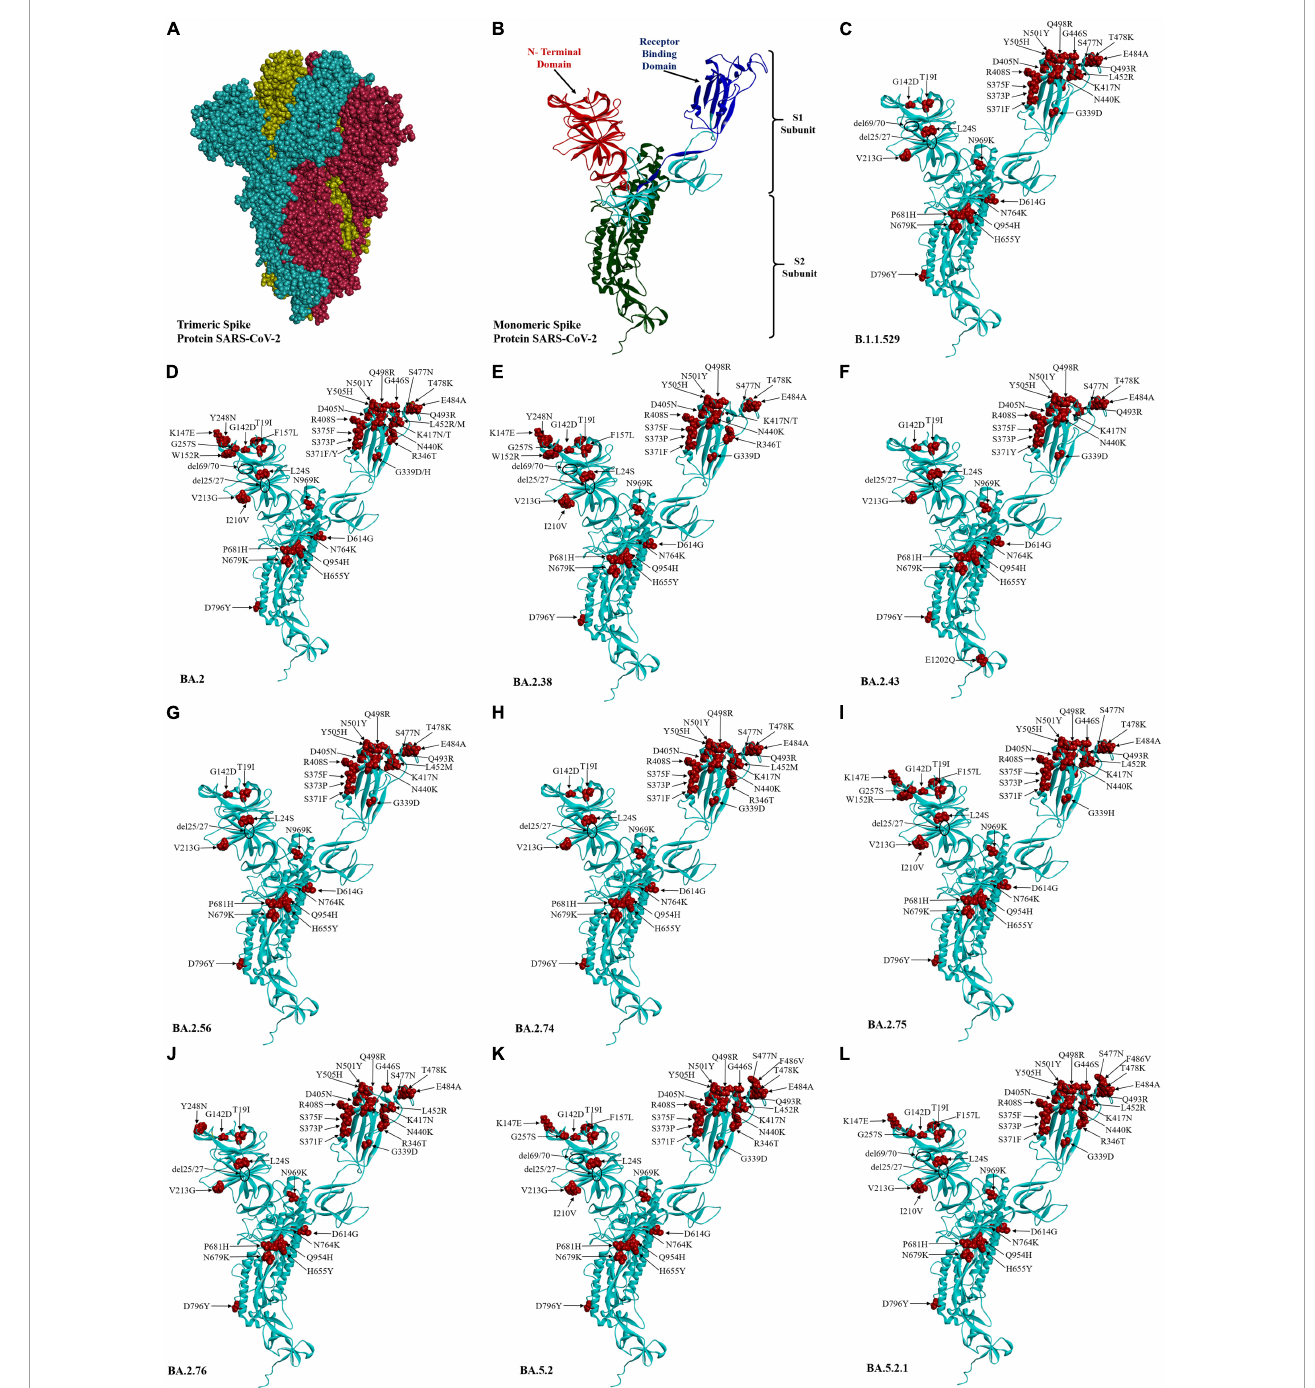
FIGURE4 Three-dimensional structure and amino acid residue mutations in the spike protein of SARS-COV-2 Omicron variant and their sub-lineages. Wuhan trimeric spike glycoprotein prototype (A) and monomeric spike glycoprotein prototype (B) in which red, blue, and green colors showed the N-terminal domain, receptor-binding domain, and S2 subunit of spike proteins, respectively. The amino acid residue substitution and deletion sites are marked in red color and circle, respectively, in Omicron sub-lineages (C–L) .